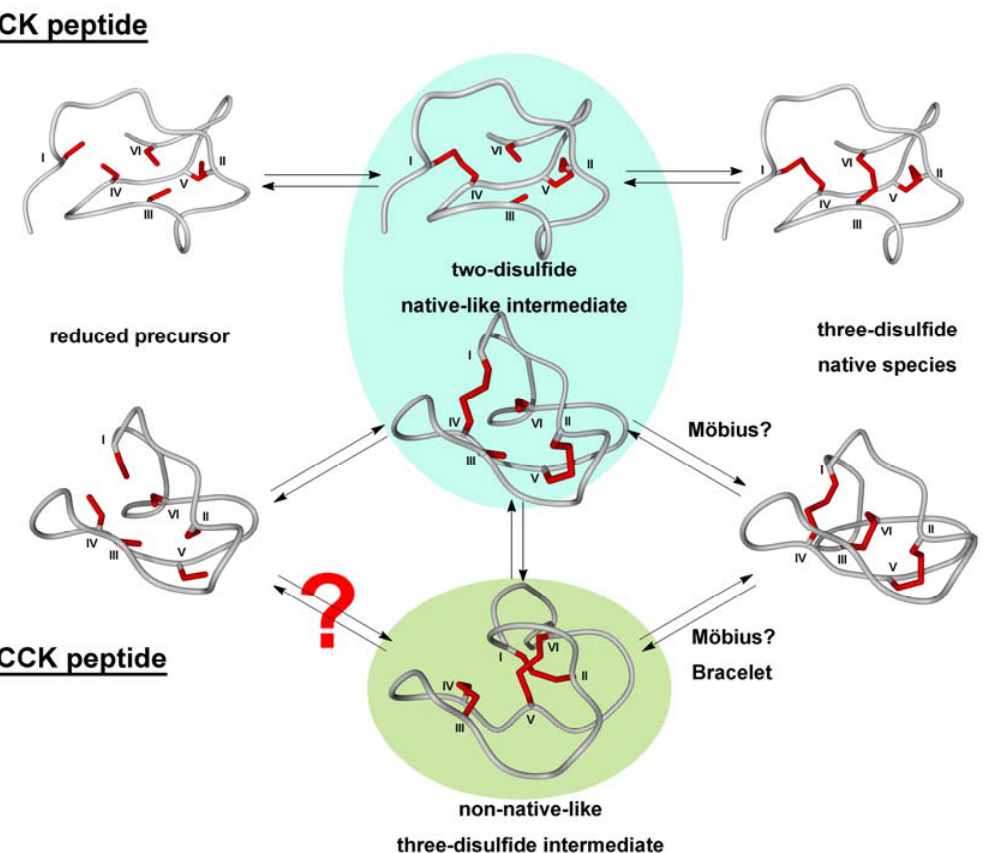
Figure 4. In vitro folding pathways of cystine-knot peptides from different families. Most ICK peptides are thought to proceed to the folded form via formation of two-disulfide native-like intermediate. Folding of CCK peptides may either follow a similar path or proceed via a non-native 3-cystine intermediate. Structures were modeled and energy-minimized with Yasara Ver.